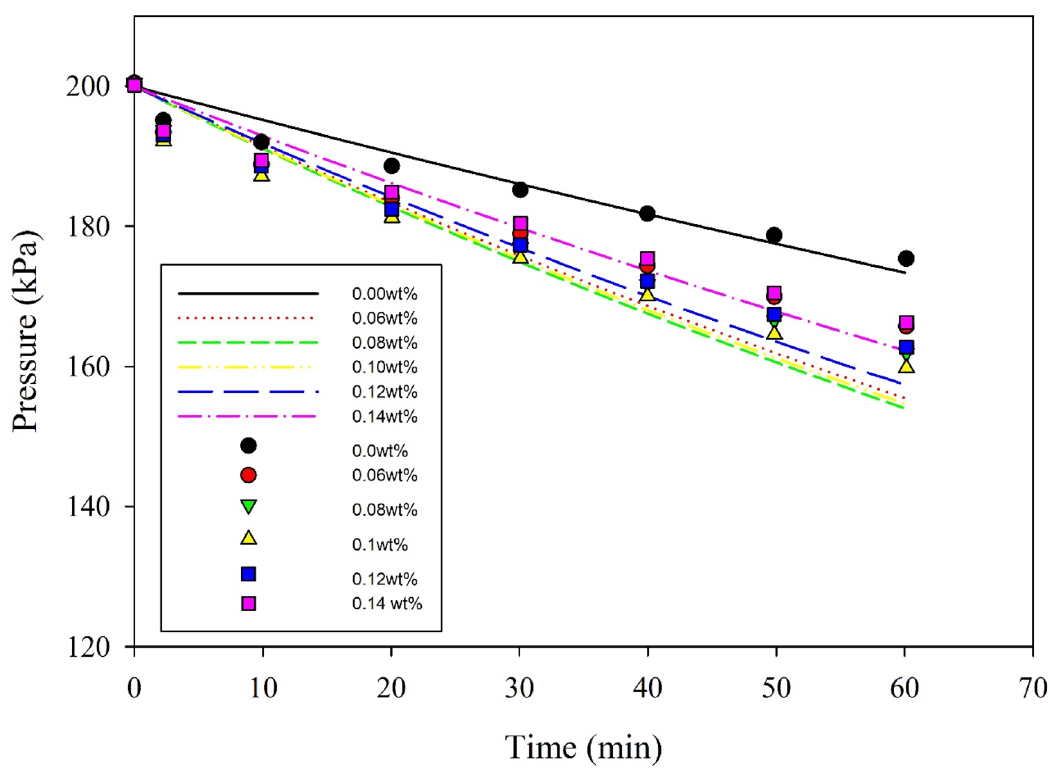
Figure 3. Comparison of developed model predictions (lines) and experimental data (no mixing, 0 RPM) available in the literature 20 for variable concentrations of TiO 2 with 10 nm nanoparticles at 25 °C. The solid lines represent the model